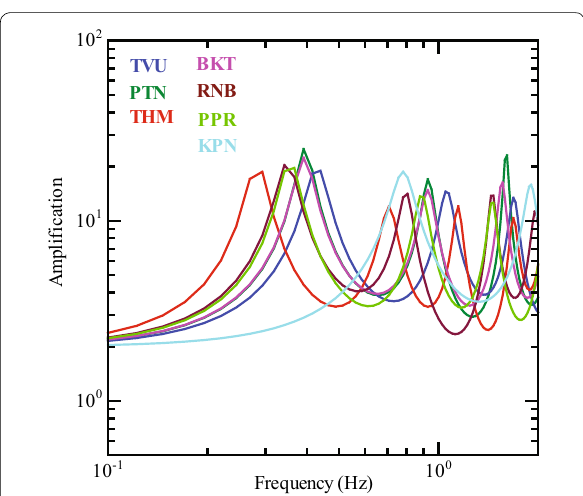
Fig. 16 Theoretical amplification factors for the sedimentary sites calculated using the Propagator Matrix method. There is a difference in fundamental peak between the sites, and significant amplification is clearly evident in the low-frequency